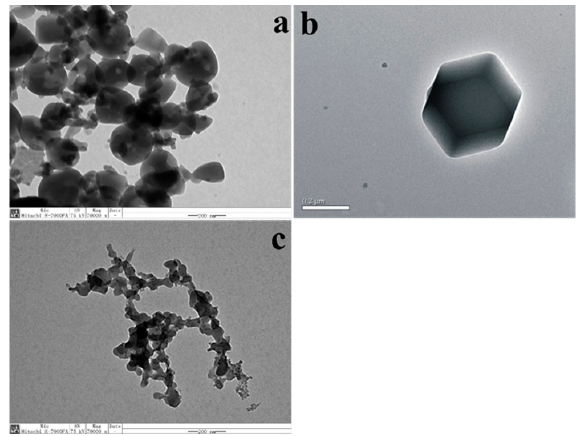
Figure 2. TEM images: ( a ) hierarchical ZIF-8; ( b ) hexahedral ZIF-8; ( c ) BCL-ZIF-8.